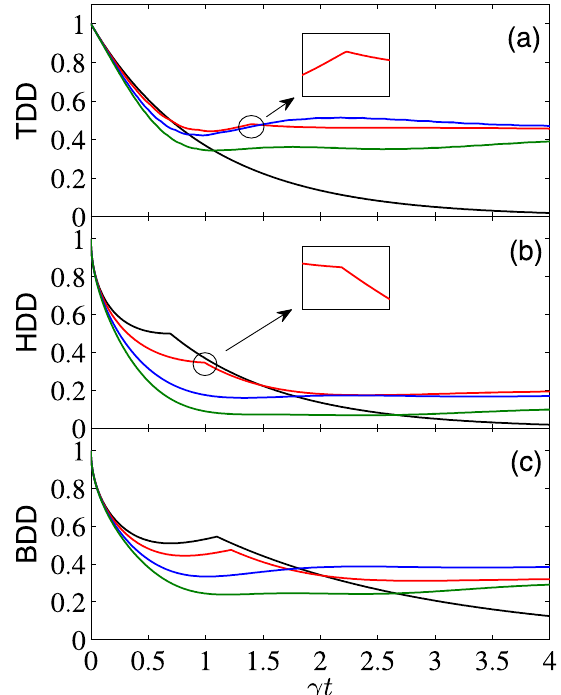
Figure 1. γ t dependence of TDD, HDD, and BDD (in units of J ) for the initial state ψ + , with = n 0 , B = 0, and Δ = 0 (black), 0.3 (red), 0.7 (blue), and 1 (green). Moreover, the black line overlaps with that for noninteracting